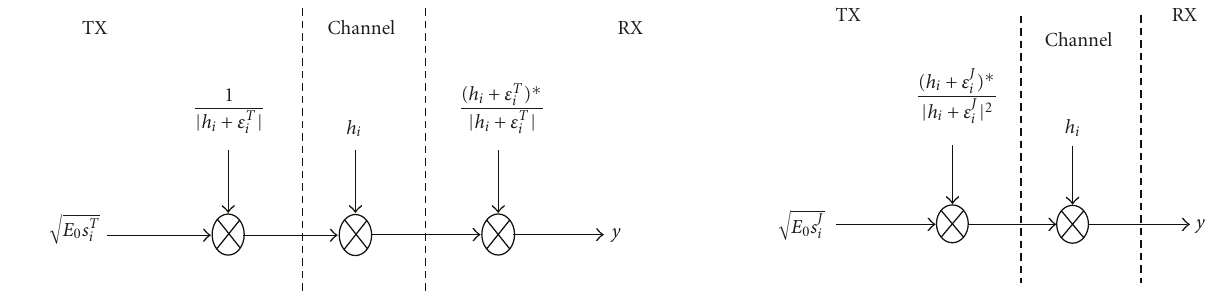
Figure 9: Single transmitter in TDMA. Figure 10: Single transmitter in